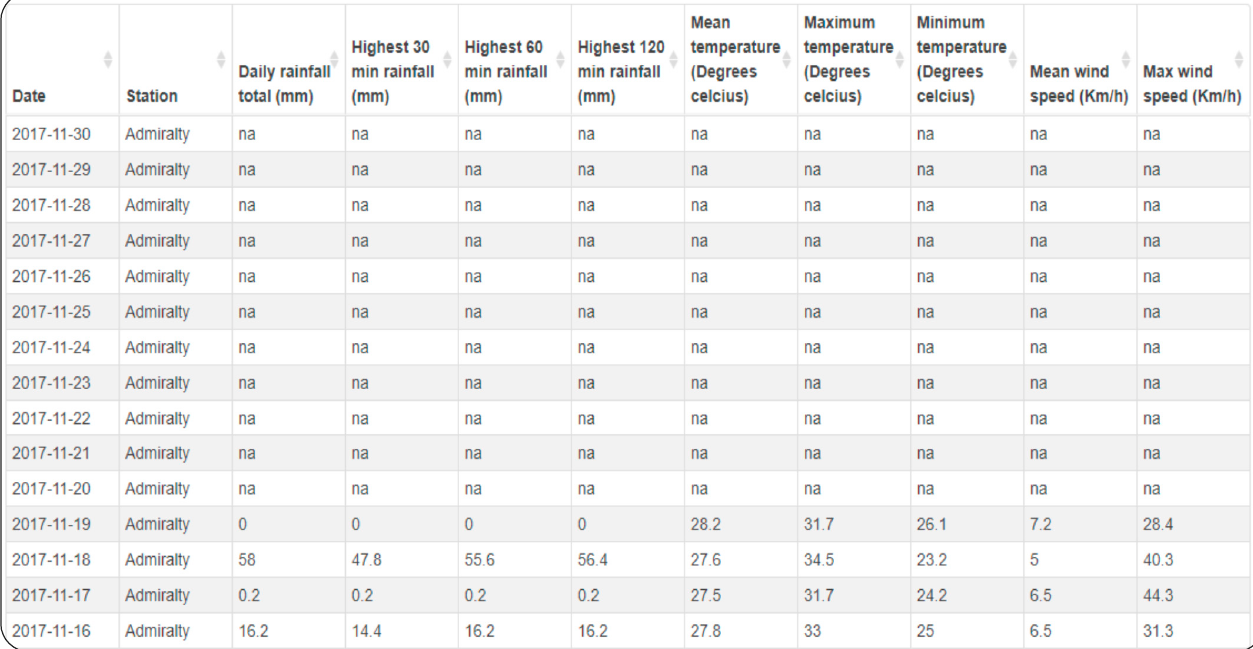
Table 3. The utilized configuration parameters for DT model.